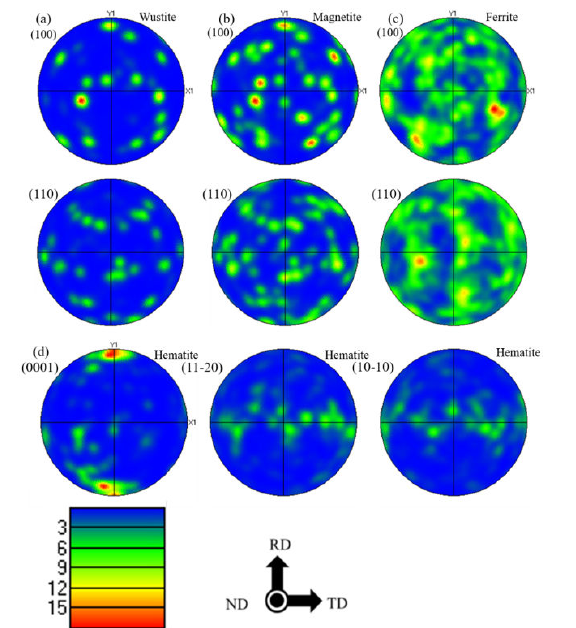
Figure 11. Polar diagrams of an oxide layer and steel matrix on different crystal planes for ( a ) FeO, ( b ) Fe 3 O 4 , ( c ) ferrite, and ( d ) (0001), (10 − 10) and (11 − 20) PF for Fe 2 O 3 , with a TR of 27%, and a CR of 27 ◦